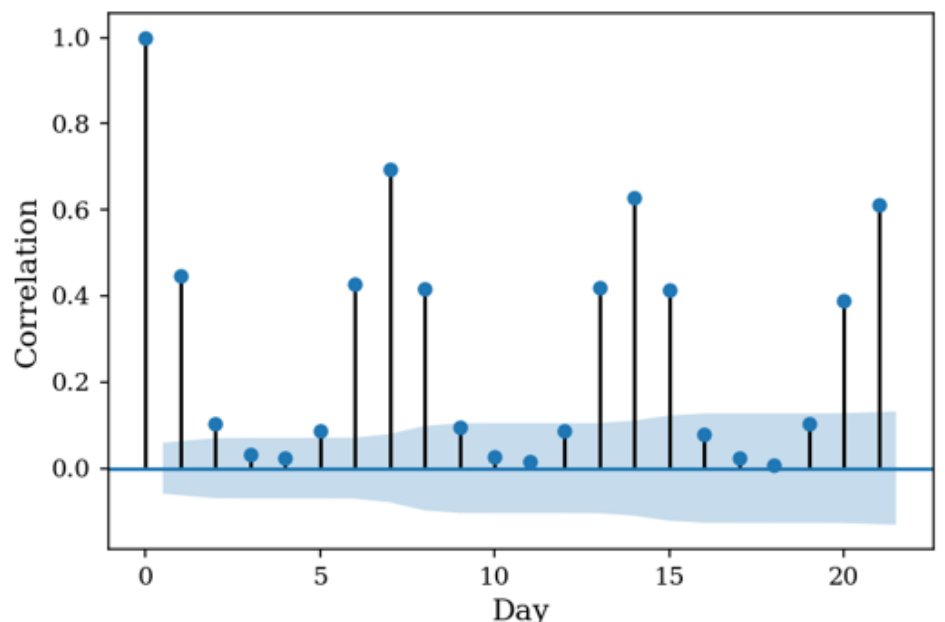
Figure 3. Autocorrelation of Sales Between Today and 28 Previous Days. The correlation score from 0–1 shows how highly correlated past days are with the current day 0. Due to weekly seasonality, correlation spikes every 7 days far into the past. The blue range represents confidence, and any day that scores within the threshold is considered not correlated.